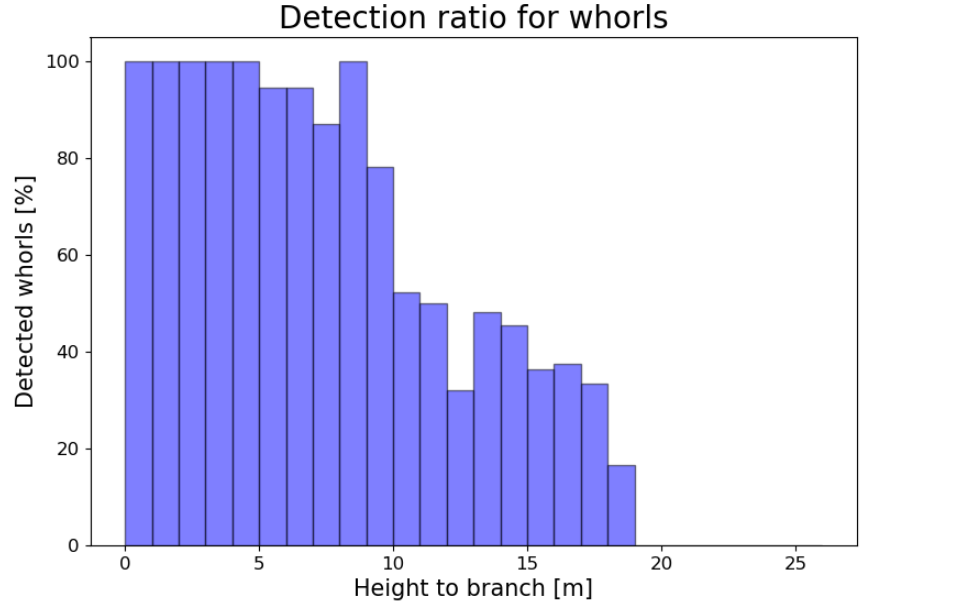
Figure 5. Detection rate of the branch whorls as a function of height from ground. Most of the branch whorls are detected up to a 10 meter height from the ground. Table 2. Amount of detected whorls in terrestrial laser scanner data for each sample tree, for all trees, and for all trees at the height interval 0–10 m from the ground. Tree